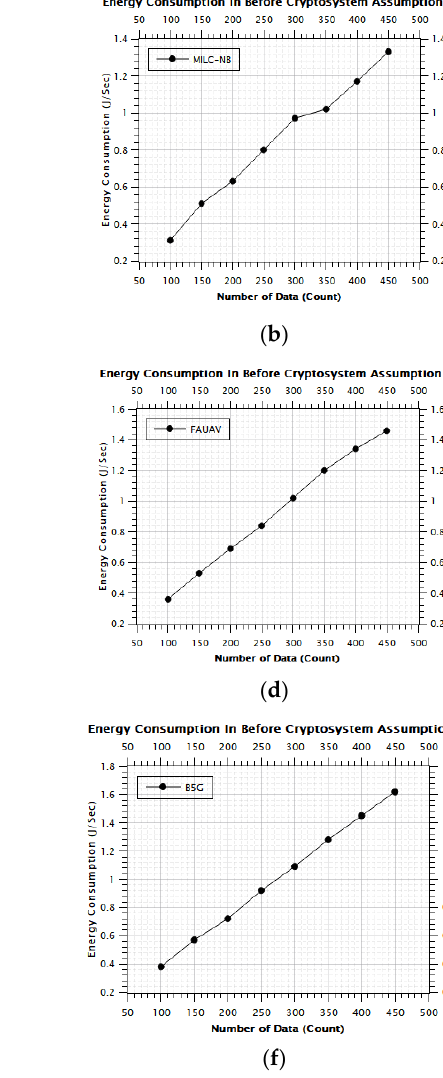
Figure 11. The energy consumption after cryptosystem assumption. ( a ) Energy Consumption In Before Cryptosystem (ASA), ( b ) Energy Consumption In Before Cryptosystem (MILC-NB), ( c ) Energy Consumption In Before Cryptosystem (MCCMDC), ( d ) Energy Consumption In Before Cryptosystem (FAUAV), ( e ) Energy Consumption In Before Cryptosystem (CAN), ( f ) Energy Consumption In Before Cryptosystem (B5G). The proposed method, assuming the use of a Cryptosystem, increases the Total Table 6. Analysis of Energy Consumption after Cryptosystem packet delivered by approximately CAN [28] 6.43%, MILC-NB [3] 50.55%, MCCMDC [38] 52.73%, FAUAV [2] 5.80%, B5G [7] 58.35%, and ASA 60.23% improved, according to Table 6’s results of the analysis (Figure 12a–f) of Energy Consumption assuming the use of a Cryptosystem. In terms of the proposed scenario’s Data classification improvement percentage, the proposed method outperformed the MILC-NB algorithm by about 6.43%, the MCCMDC algorithm by about 50.55%, the FAUAV algorithm by about 52.73%, the CAN algorithm by about 55.80%, and the Data classification improvement percentage Analysis ASA algorithm by about 60.23%.